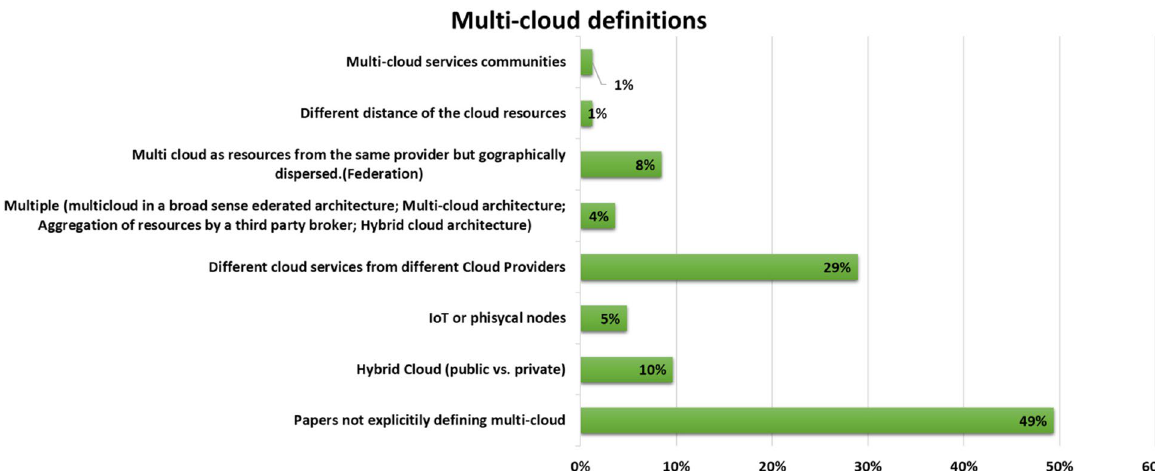
Fig. 14 Classification of Primary Studies based on their multi‑cloud